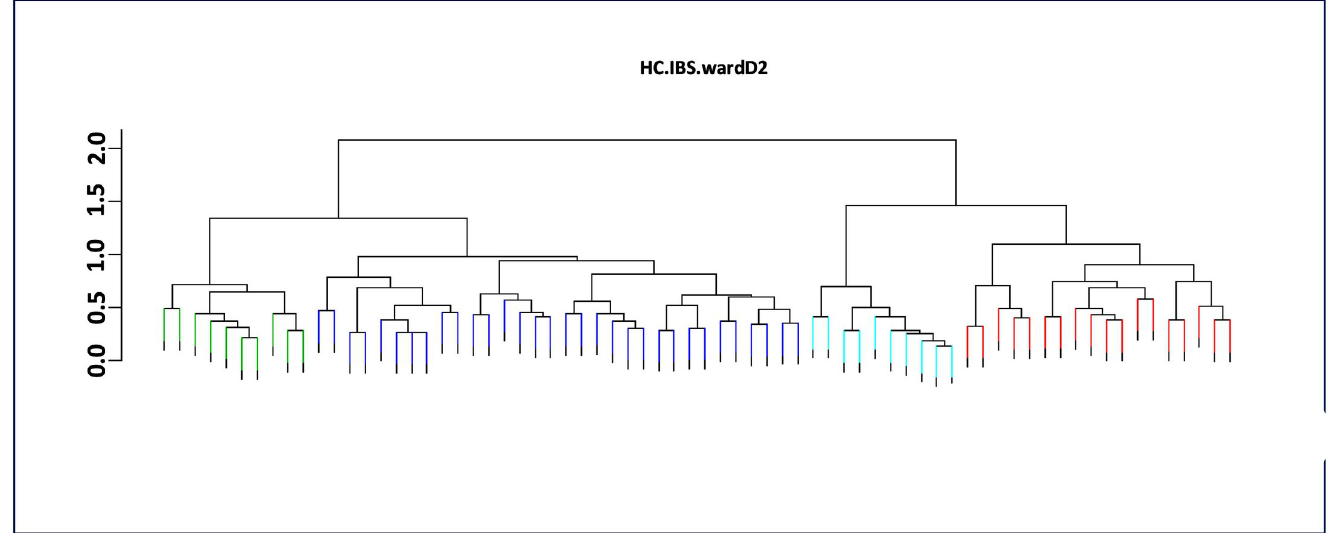
Fig 2. Phylogenetic tree among 70 cowpea accessions studied revealed by Ward’s minimum variance method. https://doi.org/10.1371/journal.pone.0252362.g002 accessions from Savane and Plateaux regions, while population 2 had almost equal access to each region. Regarding the seeds coat color, subpopulation 1 was the most heterogeneous and included 66.67% of white-colored seeds, 11.11% of beige red-colored seeds, 8.89% of red wine- colored seeds and 4.44% of burgundy purple-colored seeds, while subpopulation 2 included